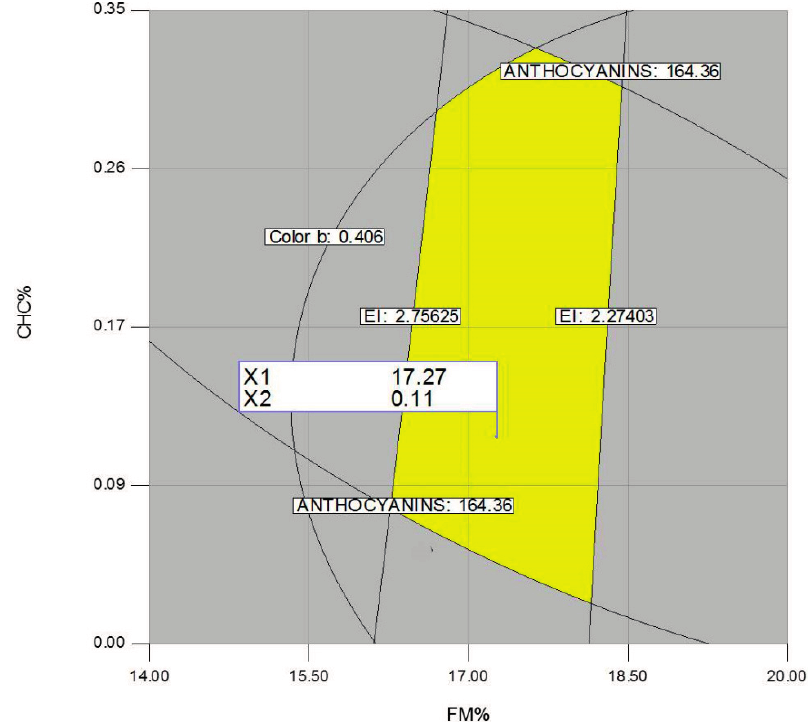
Figure 8. Overlay plot and optimized region (best combination) of the extrusion processing factors feed moisture (FM) and calcium hydroxide concentration (CHC), for producing expanded nixtamalized blue corn extrudates.